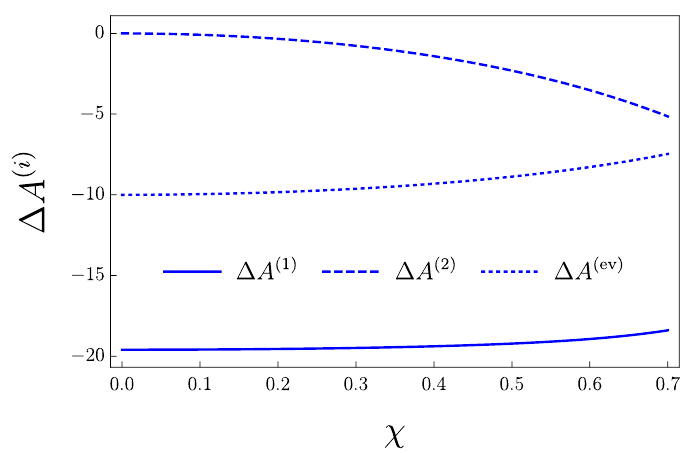
Figure 3 . Variation of the black hole area (cid:1) A ( i ) due to every one of the corrections. The quadratic curvature corrections, controlled by (cid:11) 1 and (cid:11) 2 always decrease the area with respect to the result in Einstein gravity, while for the even cubic correction the contribution depends on the sign of (cid:21) ev